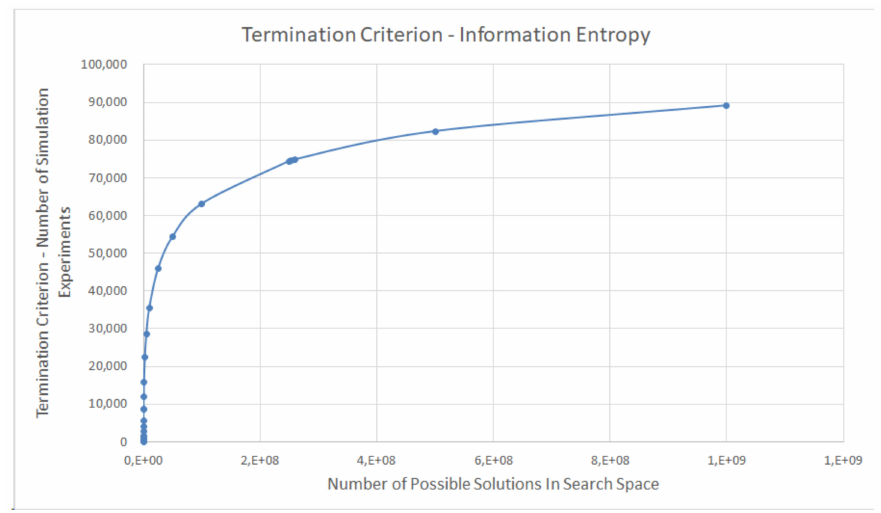
Figure 10. Derived second termination criterion using information entropy.